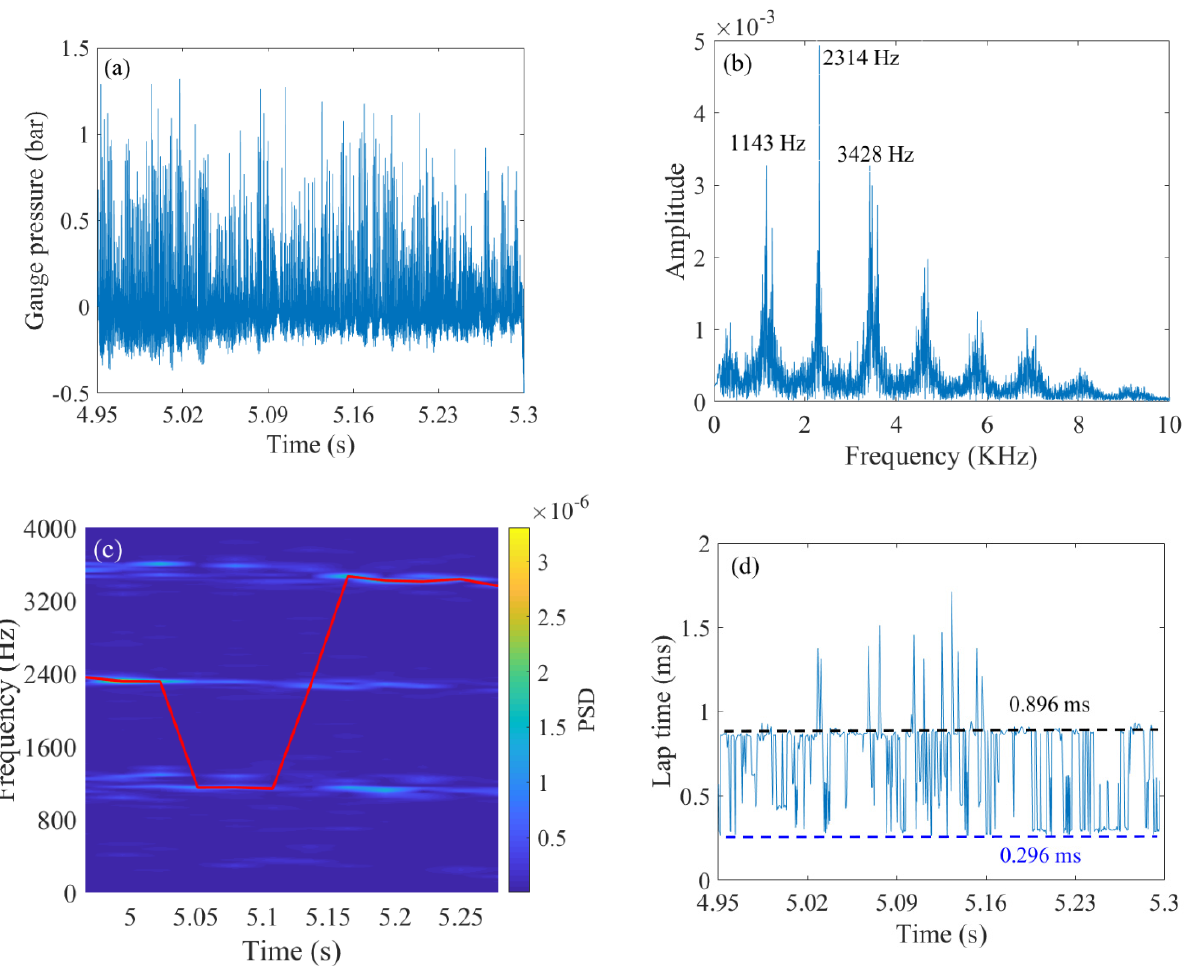
Figure 8. The rotating detonation experiment of B14: ( a ) filtered signal, ( b ) frequency spectrum, ( c ) time − frequency diagram, and ( d ) lap time.